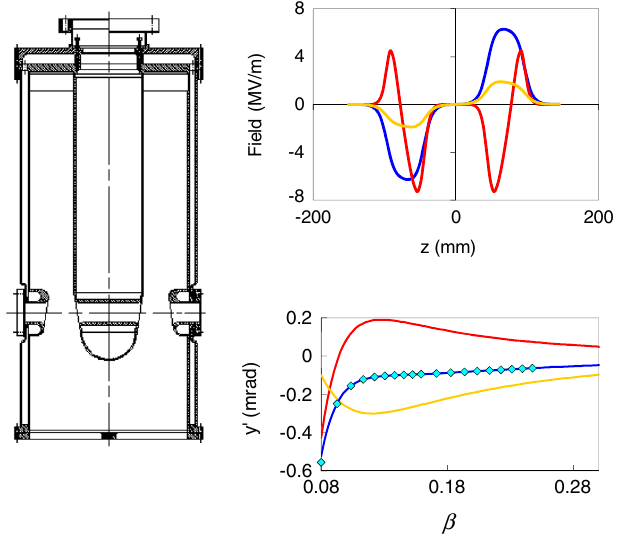
FIG. 10. Example of (cid:1) ¼ 0 : 16 , 161 MHz prototype cavity with tilted beam ports for steering correction [12]. Right top: (cid:4) 10 (red line) (blue), cB (yellow), and E field distributions E z x y with the correcting bumps generated by 9 degrees beam port tilting. Right bottom: steering at 1 MV = m , (cid:2) ¼ (cid:1) 30 (cid:6) for pro- tons in the QWR with beam port tilting. Blue diamonds: total steering calculated by TRACEWIN and realistic 3D field maps. The lines represent the model results: electric (red), magnetic (yellow), and total steering (blue), fitting rather well the 3D simulation